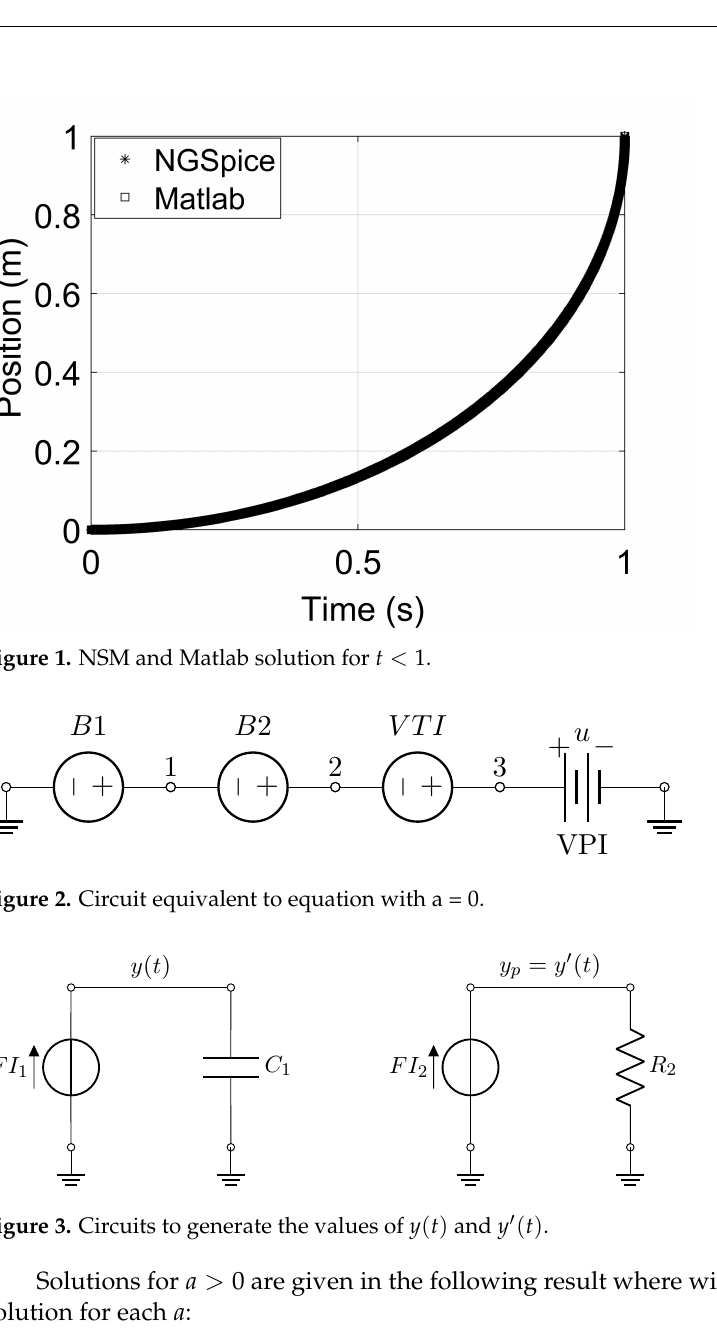
Figure 1. NSM and Matlab solution for t < 1